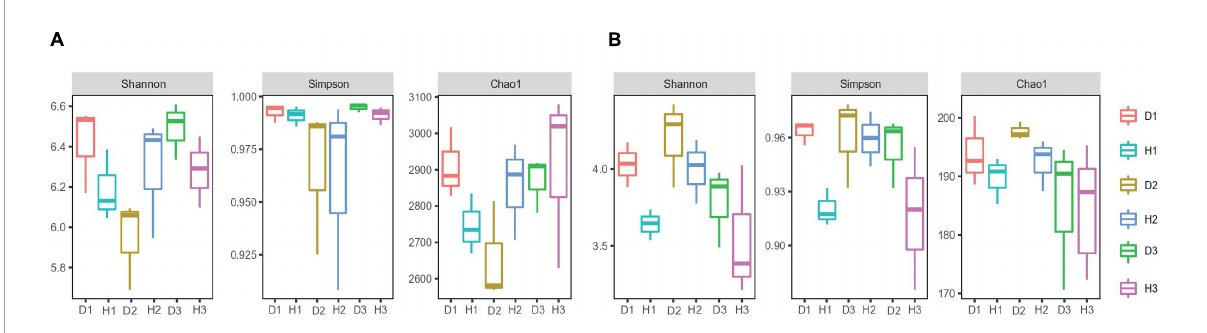
FIGURE1 Microbial alpha diversity. The α -diversity indices of soil bacterial (A) and fungal (B) communities in the soils of healthy and diseased oil peony, Chao1 index for calculating bacterial abundance, Shannon index, and Simpson index for calculating bacterial diversity, respectively.